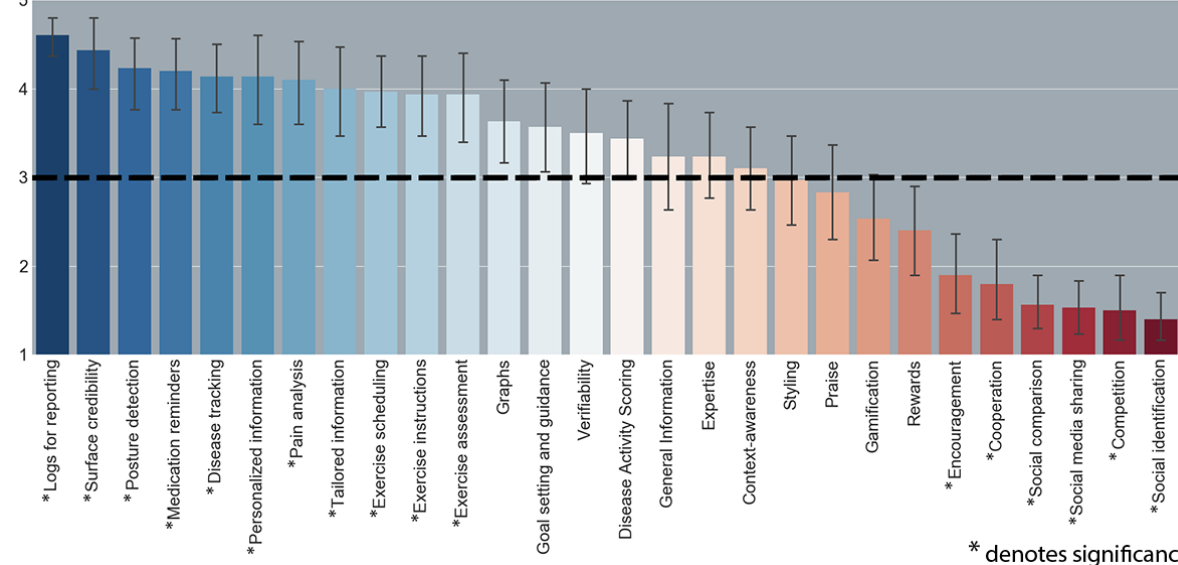
Figure 2. Scores of features in the group of disease action support. The white dot denotes the mean value, the horizontal black bar denotes the median value, the thick black bar denotes the interquartile range and the thin black bar denotes the 95% confidence interval.